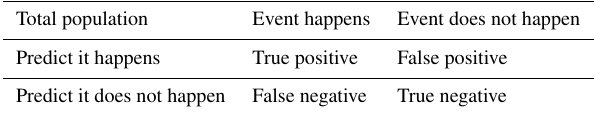
Table A1. A 2 × 2 contingency table showing the possible out- comes of a binary classifier system.